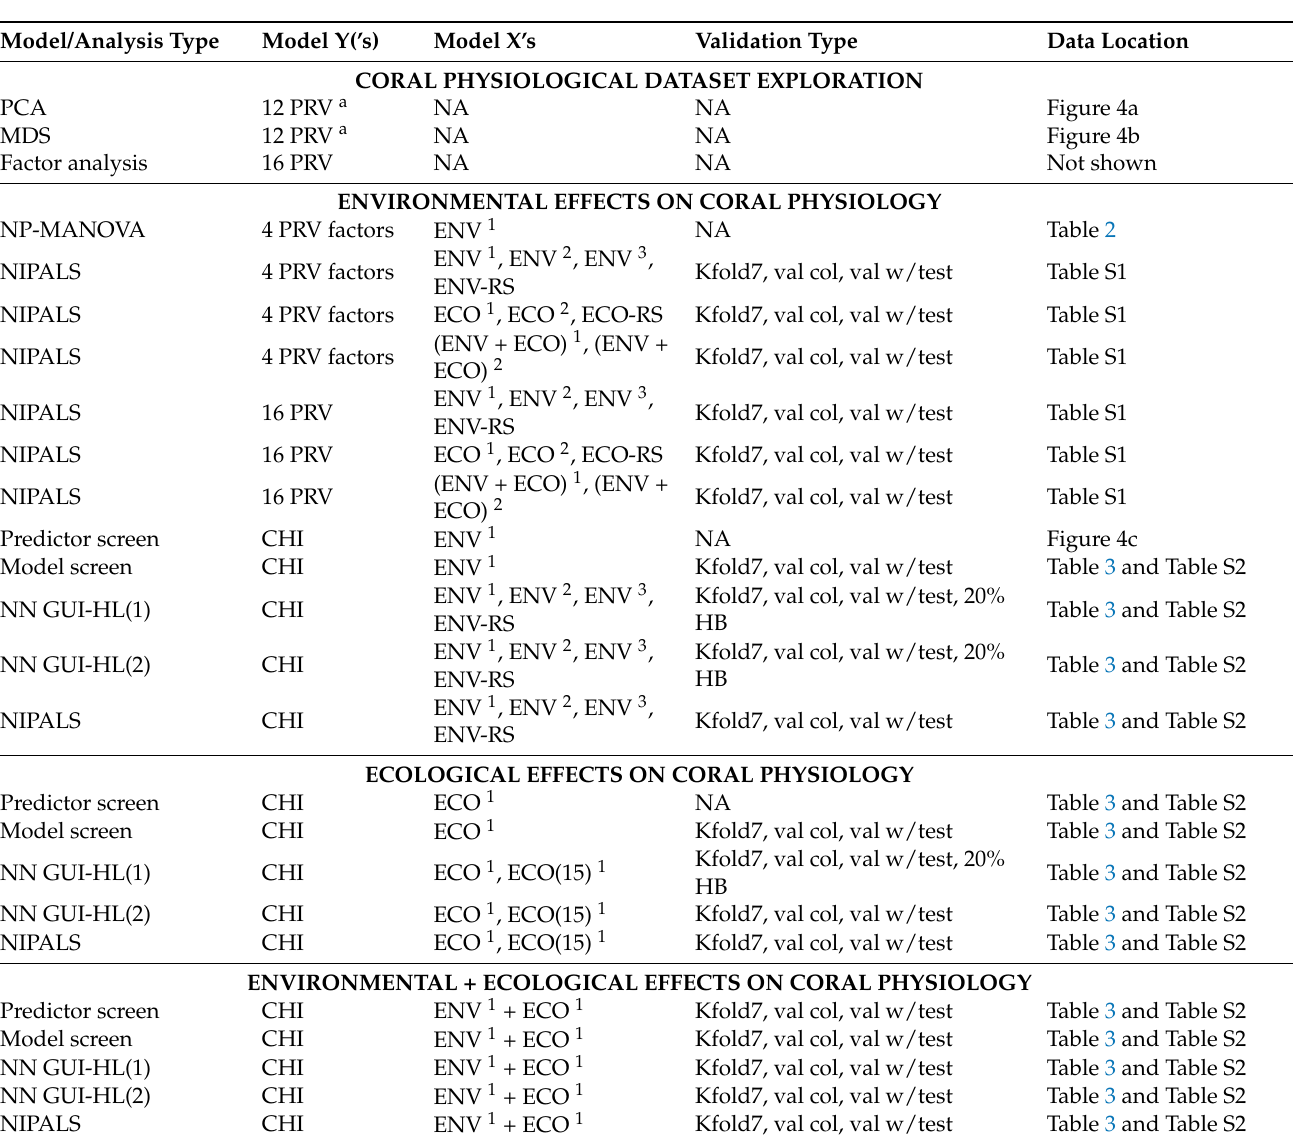
Table 1. Environmental (ENV) effects on coral physiology. For the multivariate analyses, either all coral physiological response variables (PRV) were considered (“16 PRV” or “12 PRV,” depending on the analysis) or the factor loading scores derived from a factor analysis of these PRV were analyzed (“4 PRV factors,” which explained 84% of the variation). In addition to all 50 benthic categories found in the vicinity of the sampled corals (“ECO”), the 15-factor loading scores from a factor analysis of the benthic data were also considered (“ECO(15)”). Those NIPALS (non-iterative partial least squares [PLS]) models whose PRESS was minimized with zero factors (i.e., no statistically meaningful conclusion) are instead found in Tables S1 and S2 (Supplementary File S1) for the multivariate and univariate (coral health index [CHI]) data, respectively. Superscripts following values in the “Model X’s” column denote the factorial degree (1st, 2nd, or 3rd). HB = holdback. HL = hidden layer. MDS = multi-dimensional scaling. NA = not applicable. NN = neural network. NP-MANOVA = non-parametric multivariate ANOVA. PCA = principal components analysis. RS = response surface. Val col = validation column. Val w/test = both validation and test data columns used for